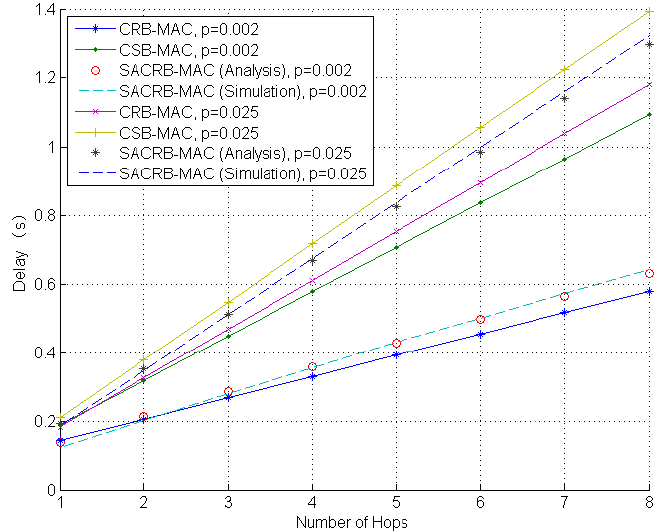
Figure 5. Multi-hop delay performance against number of